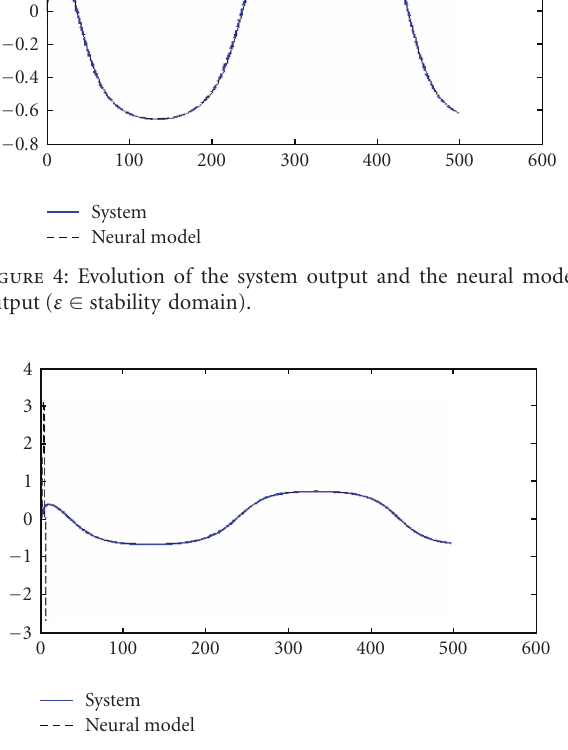
Figure 5: Evolution of the system output and the neural model output ( ε / ∈ stability